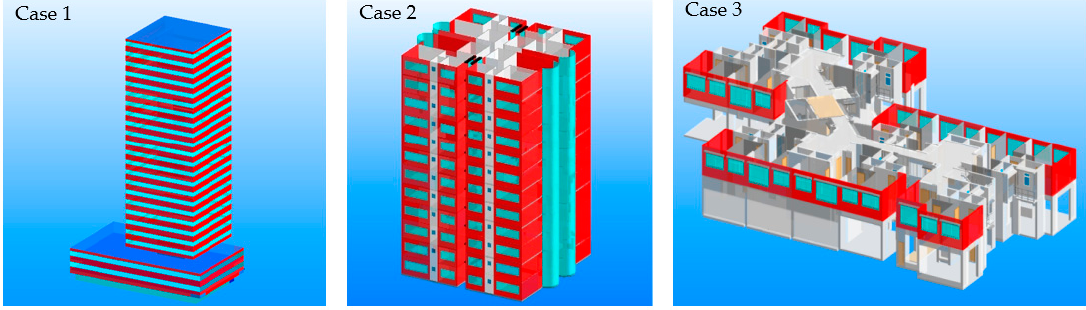
Figure 21. Models for validation.